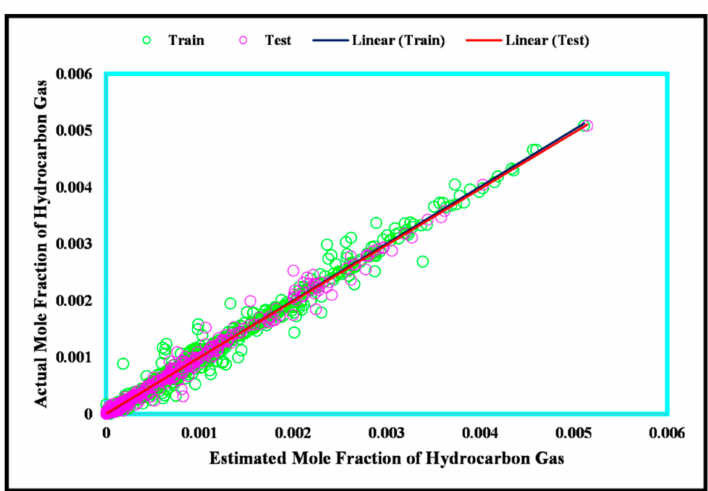
Figure 4. Cross plot of actual and estimated solubility of